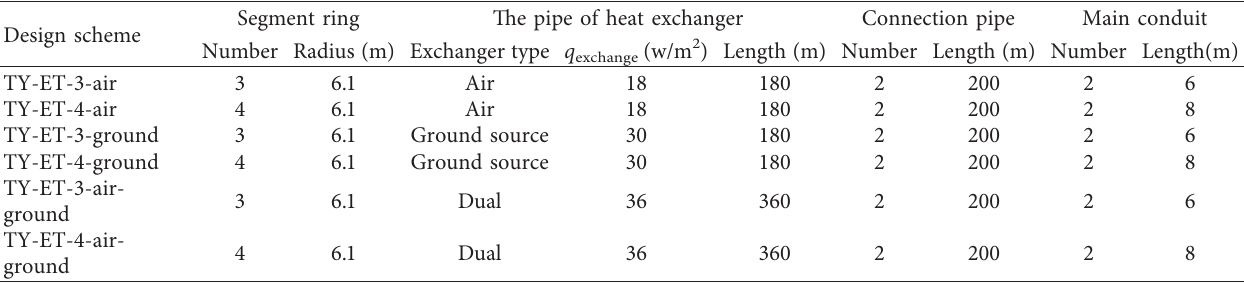
Table 3: Details of six design schemes.